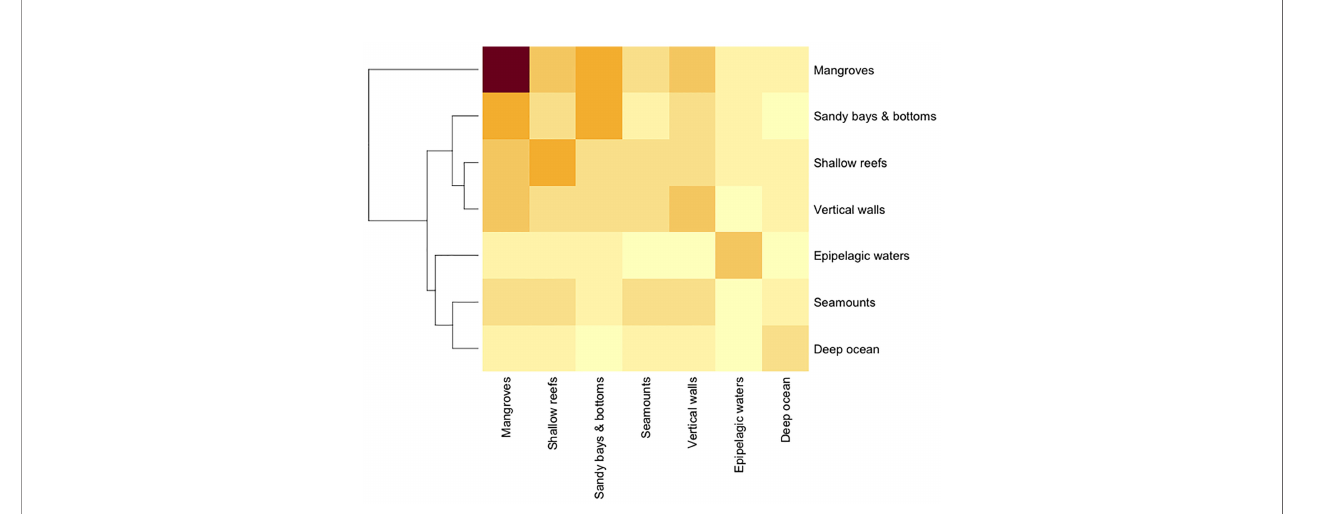
FIGURE 2 | Heatmap depicting similarities among different coastal and marine habitats in the Galapagos in terms of shared species, according to fi shers ’ LEK. Darker coloration depicts higher species richness (diagonally) or higher similarity between habitats (non-diagonally). Dendrograms represent relative similarity relationships among these